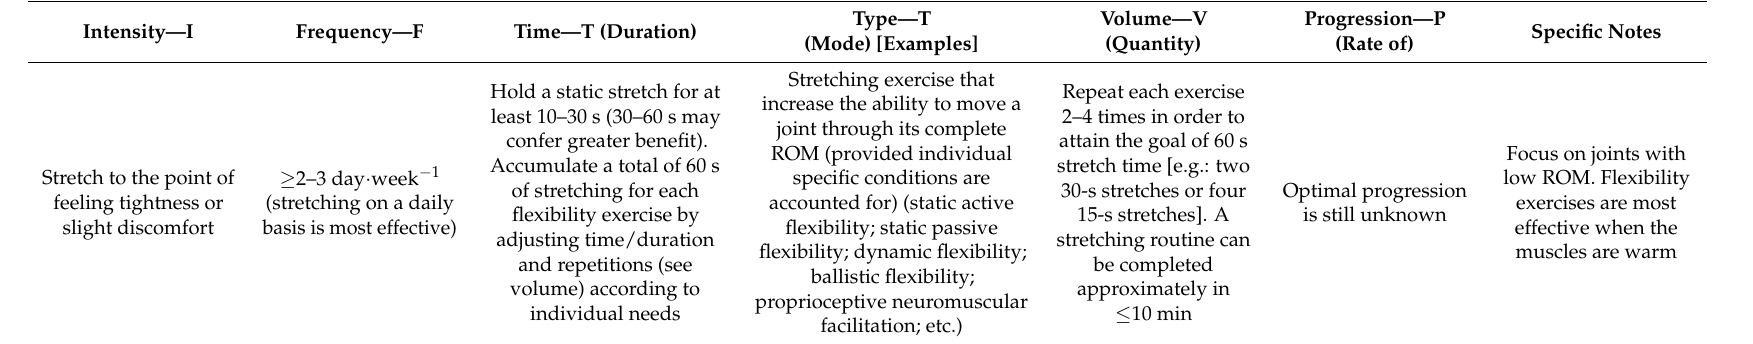
Table 3. Flexibility (stretching) exercise recommendations for ageing postmenopausal women.